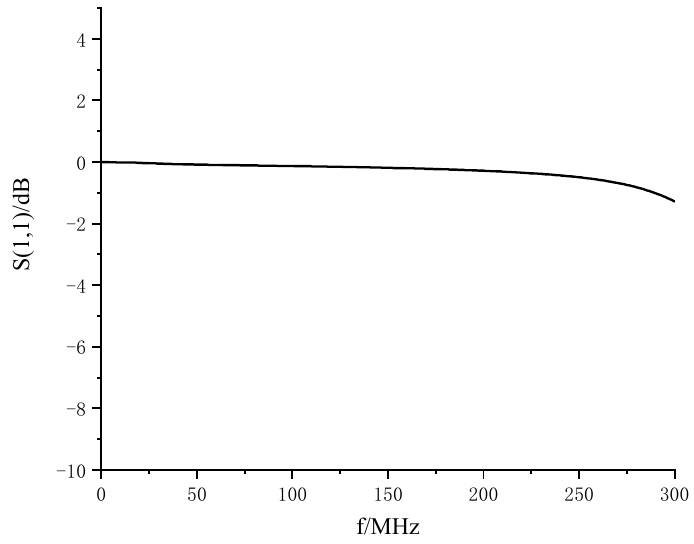
Figure 14. Transmission parameters of the probe port S 11